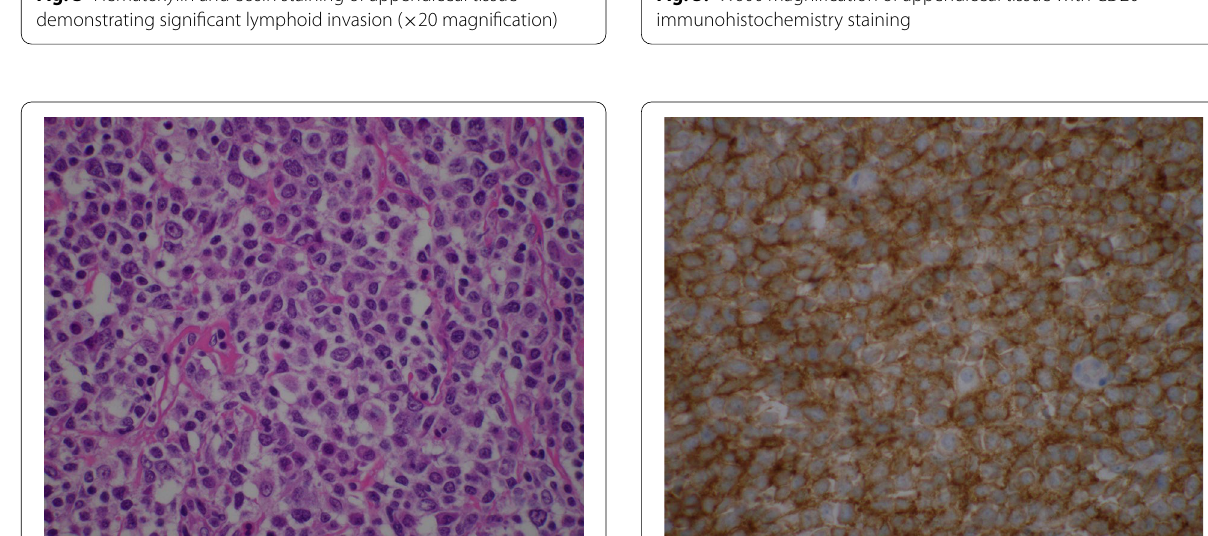
600 Fig. 6. 600 Magnification of appendiceal tissue with CD10 × × immunohistochemistry